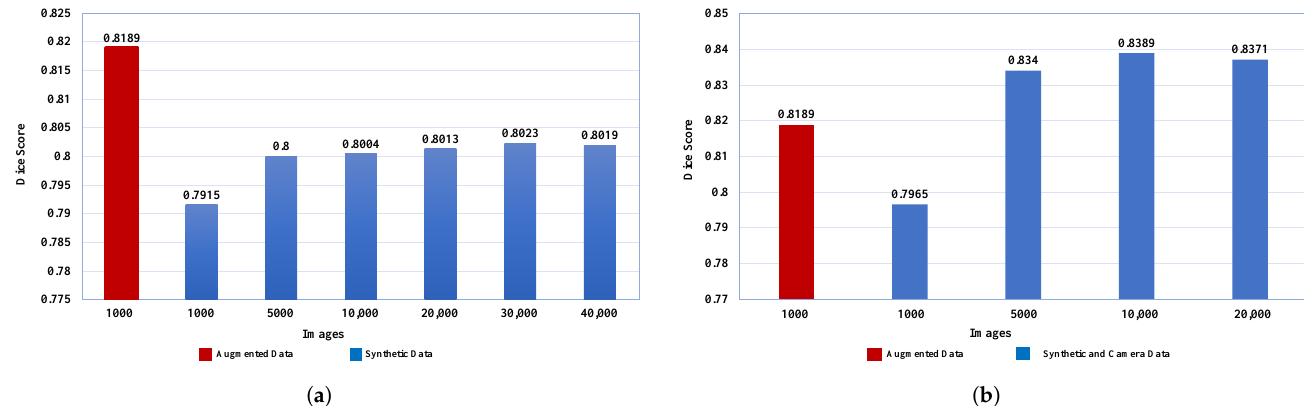
Figure 5. Test results of the U-Net model trained on ( a ) synthetic data only and a combination of ( b ) camera catheter and synthetic catheter